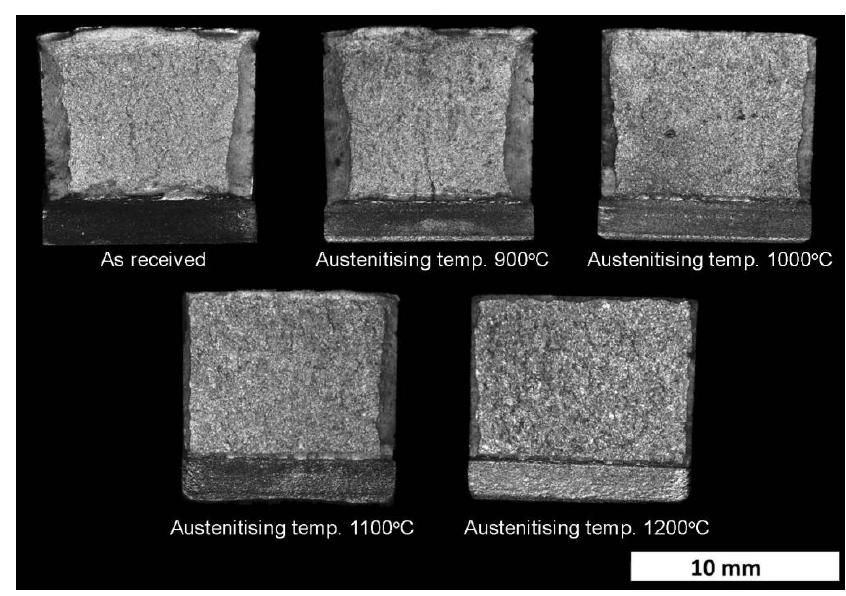
Figure 11. Macroscopic view of the fractures that occurred after the Charpy impact strength test of the as-received state sample and the samples austenitized at different temperatures.